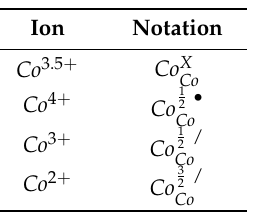
Table A1. Cobalt ions